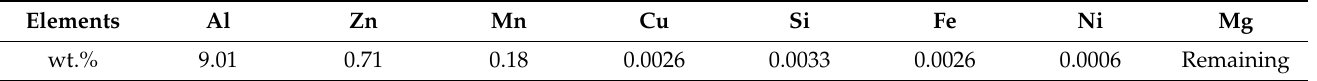
Table 1. Chemical composition of the AZ91 alloy used in this